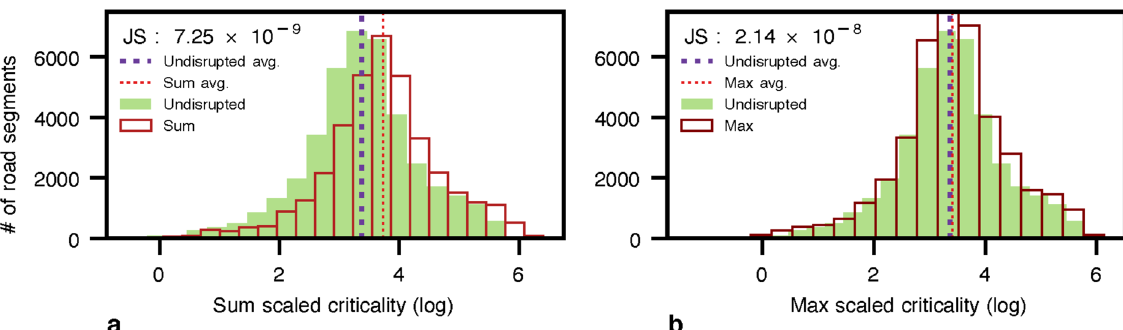
Figure 8. Criticality distribution for compound hazard fault line and flood for Lima city in log scale. Where (a) is the baseline and the compound hazard flood of flood planning hazard map at historical return period and fault line with a return period of 50 and 100 years taking the sum of both values, and (b) is the baseline and the compound hazard flood of flood planning hazard map at historical return period and fault line with a return period of 50 and 100 years taking the maximal value. The Jensen-Shannon divergences are 7.25 × 10 − 2.14 × 10 − 8 for (a) and (b) with respect to the undisrupted